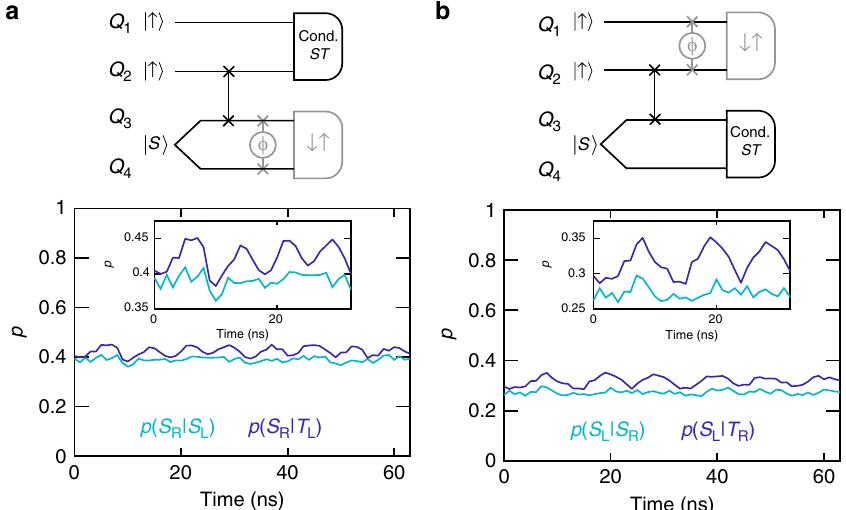
Fig. 3 Veri fi cation of conditional teleportation of a classical state. a We apply an exchange pulse to qubits 3 and 4 after measuring qubits 1 and 2. Here, ϕ = 2 π J t , where J t is the evolution time given by the x -coordinate of each data point. 34 34 is the induced exchange coupling between qubits 3 and 4, and ( ϕ = π corresponds to a SWAP operation.) When the left pair give a singlet, the right pair have the same spin, and no oscillations should be visible. The inset shows the same data from 0 to 32 ns. b Applying an exchange pulse to the left pair after measuring the right pair generates exchange oscillations on the left pair only if the right pair yields a triplet. The inset shows the same data from 0 to 32 ns. Here, ϕ = 2 π J 12 t , where J 12 is the induced exchange coupling between qubits 1 and 2. In both panels, each data point represents the average of 16, 384 single-shot measurements, and the gray elements of the circuits serve to verify teleportation.